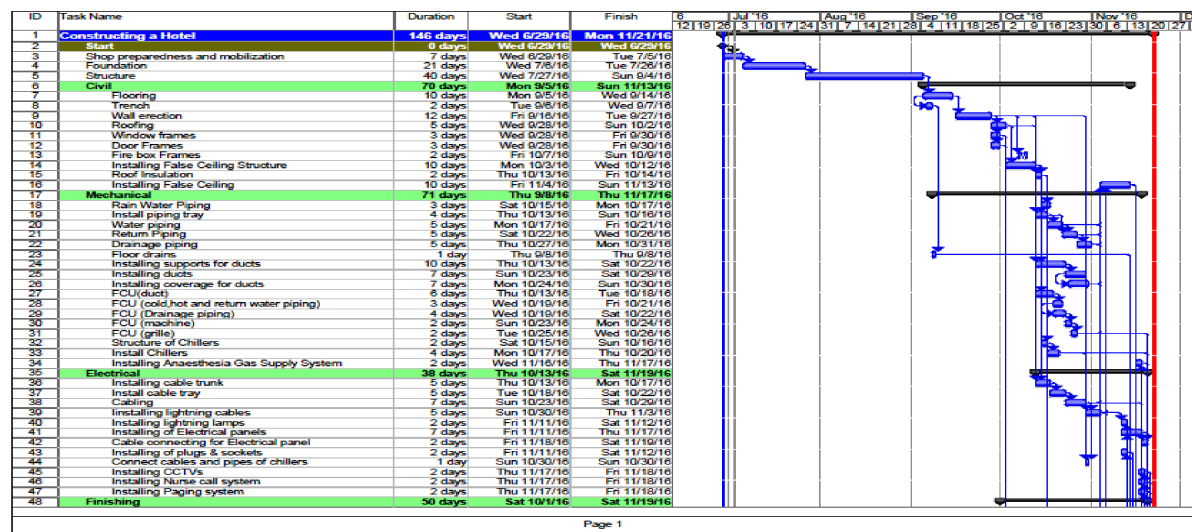
Figure 61. Gantt Chart of MSP 2010 for case study (Continued)